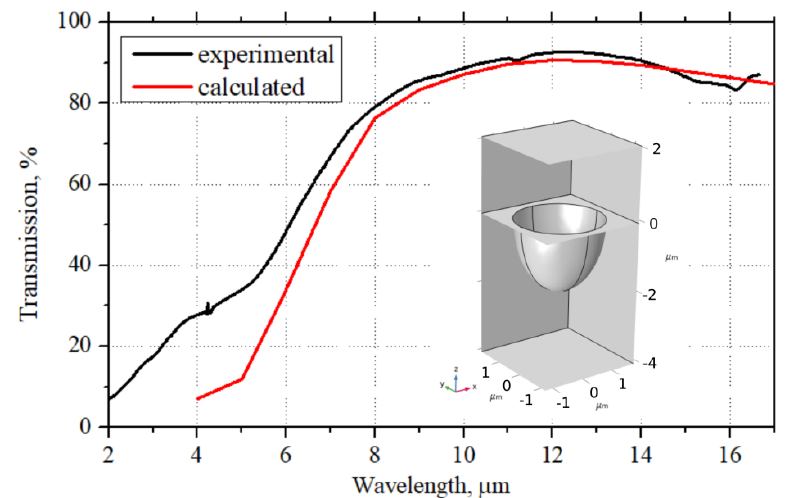
Figure 17. Transmission spectra of a GaSe crystal with ARMs on both sides: experimental data for 8 pulses, E = 37.5 nJ nJ (solid), and simulation (dashed with squares), with the modified profile of a crater in the form of a semi-ellipsoid.